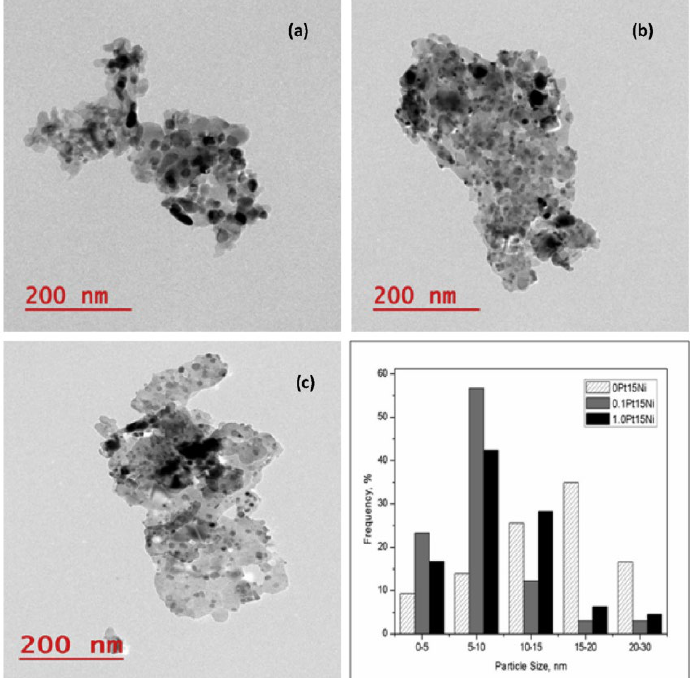
Figure 4. TEM images and active metal particle size distribution for ( a ) 0Pt15Ni, ( b ) 0.1Pt15Ni, and ( c ) 1.0Pt15Ni catalysts. Reprinted with permission from [146]. Copyright 2017, Elsevier. Katheria et al. investigated Rh-Ni/Mg(Al)O catalysts prepared by sequential impreg-